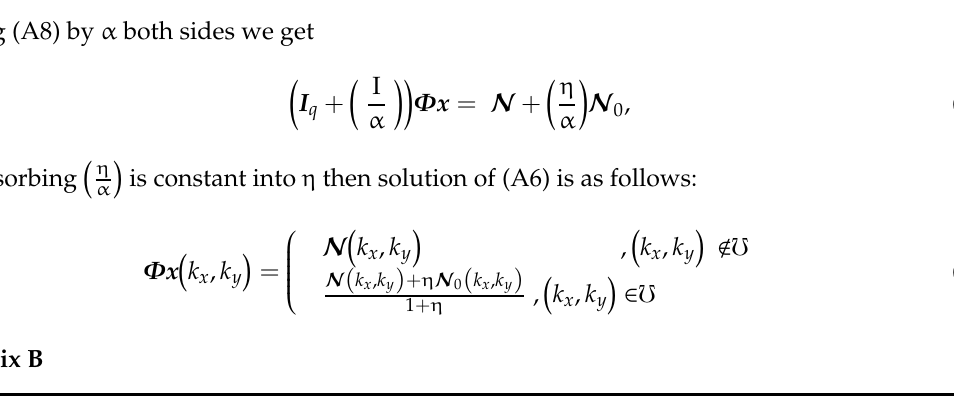
Algorithm Pseudocode : Improved reconstruction of MR scanned images by using dictionary learning